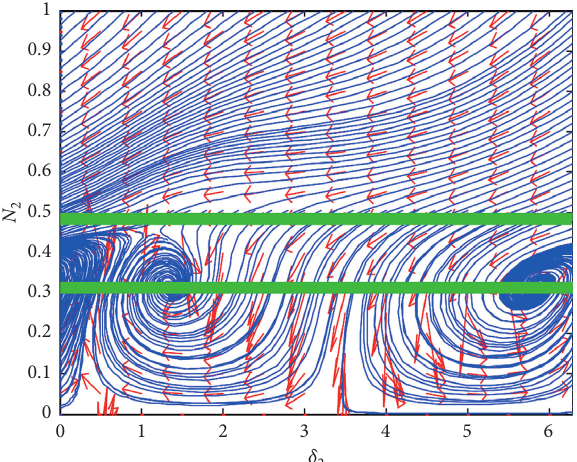
Figure 13: Phase portrait of nonlinear energy sink for the case λ